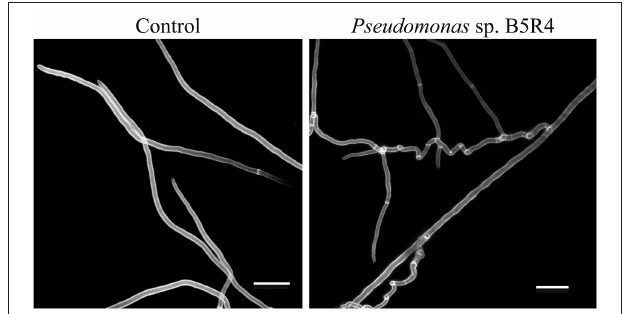
FIGURE 3 | Scanning electron microscopy images of the distortions induced in the hyphal structure of Fusarium kuroshium by VOCs emitted by avocado root endophyte Pseudomonas sp.